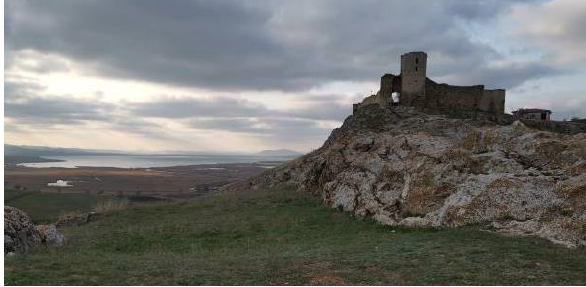
Figure 2. The Enisala citadel, facing the Babadag lake.